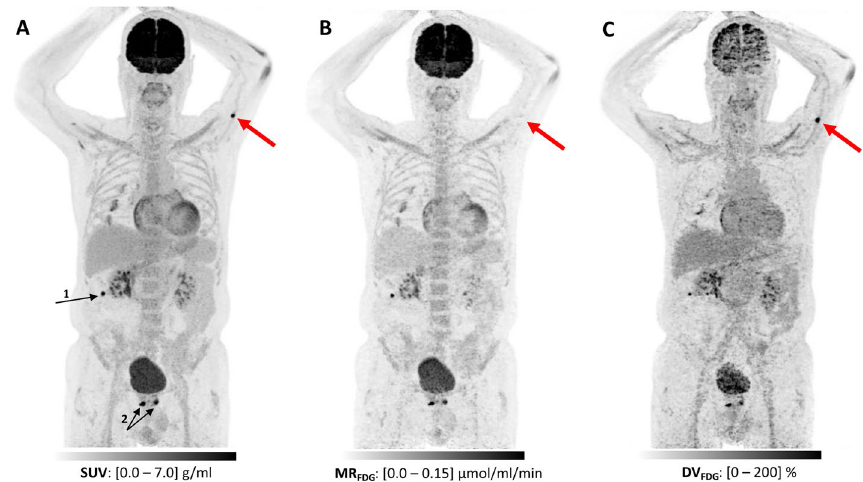
Fig. 4 MIPs of the three resulting multiparametric images from a 20-min D-WB examination with four 5 min passes from 50 to 70 min post-injection using PBIF. A SUV calculated as the average of all four passes reflecting the total 18 FDG signal; B Patlak MR FDG reflecting the metabolic rate of 18 FDG, i.e. conversion into 18 FDG-6P; C Patlak DV 18 FDG. This 85-year-old man was referred FDG reflecting the distribution volume of free for interim evaluation of treatment response after relapse of diffuse large cell lymphoma. SUV images (A), showed regression of nodes on both sides of the diaphragm, but a suspicious newcomer FDG-avid focus was described on the left arm (red arrows), and supplemental localized consolidating radiation treatment was considered. However, further analysis of the Patlak images showed this to be a false-positive finding, as there is no signal on MR FDG images (B), and the presence of signal only on DV FDG images (C) shows this to be unbound FDG. The patient was thus in disease remission and required no supplemental treatment. There were a couple other findings that required investigation. On the right side of the abdomen (black arrow 1) lies a little FDG-avid focus in the colon, in relation to a polyp that on polypectomy showed a high-grade adenoma. There were also bilateral foci in the prostate (black arrows 2). Transrectal ultra-sound could not exclude malignancy, but no biopsy was taken due to the patients’ age and comorbidities